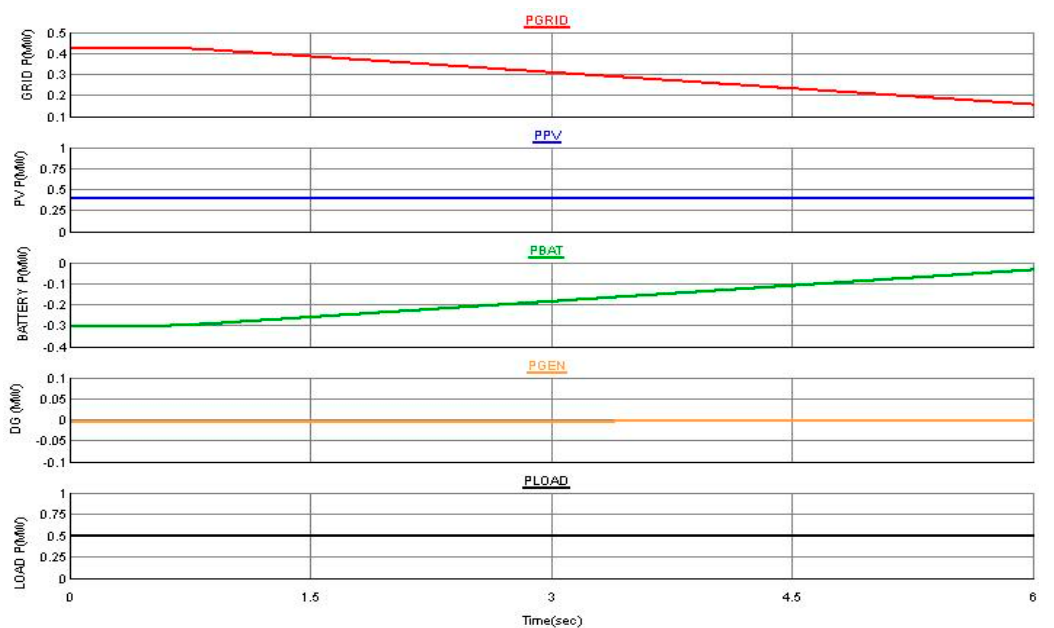
Figure 12. Grid power P GRID , PV array output power P PV , battery power P BAT , generator power P GEN and load power P LOAD.